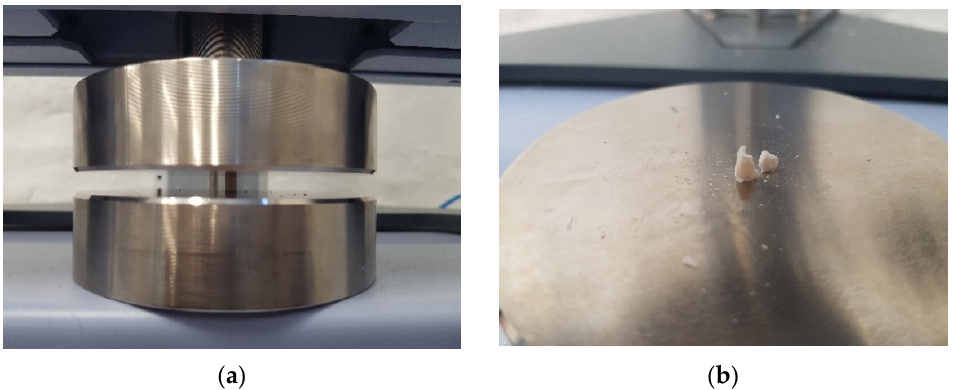
Figure 2. The testing procedure ( a ) and the specimen after testing ( b ).